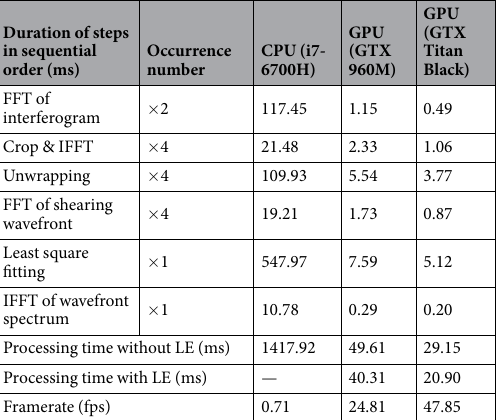
with external reference. The average spectral relative sensitivity of our WSEIM was around 2, which resulted in the achievement of wideband sensitivity enhancement. Real-time phase visualization using WSEIM. (BM-500GE, GigE Vision, JAI) employed in the experiment, the framerate of full frame is 15 fps, so the com- putation latency of phase retrieval should not exceed 66.6 ms. Although the fast and robust phase unwrapping algorithm based on noncontinuous quality-guided path 44 (NCQUAL) proposed by Herráez et al. was employed, the processing of a 2048 × 2048 interferogram pair on CPU (Intel i7-6700H, 2.60 GHz) still took 1417.92 ms (Table 1), which is obviously not available for real-time applications. To accelerate the processing speed, open source ArrayFire library based on CUDA technology which could enable the parallel computing on GPU was introduced. The time cost for the FFT of a single 2048 × 2048 interferogram which was 117.45 ms on CPU had decreased to 1.15 ms on a laptop GPU (GeForce GTX 960 M, 640 CUDA cores), and could further reach 0.49 ms